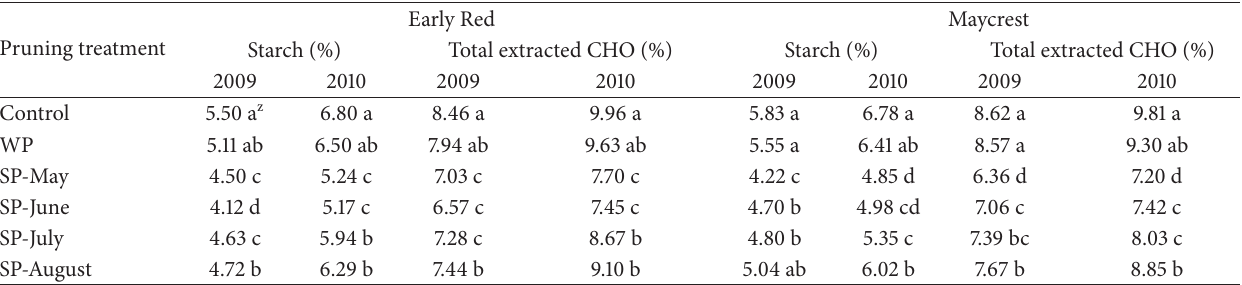
Table4:Theinfluenceofpruningtreatmentsonconcentrationofstarchandtotalcarbohydratecontentofshootof“EarlyRed”and“Maycrest” peach